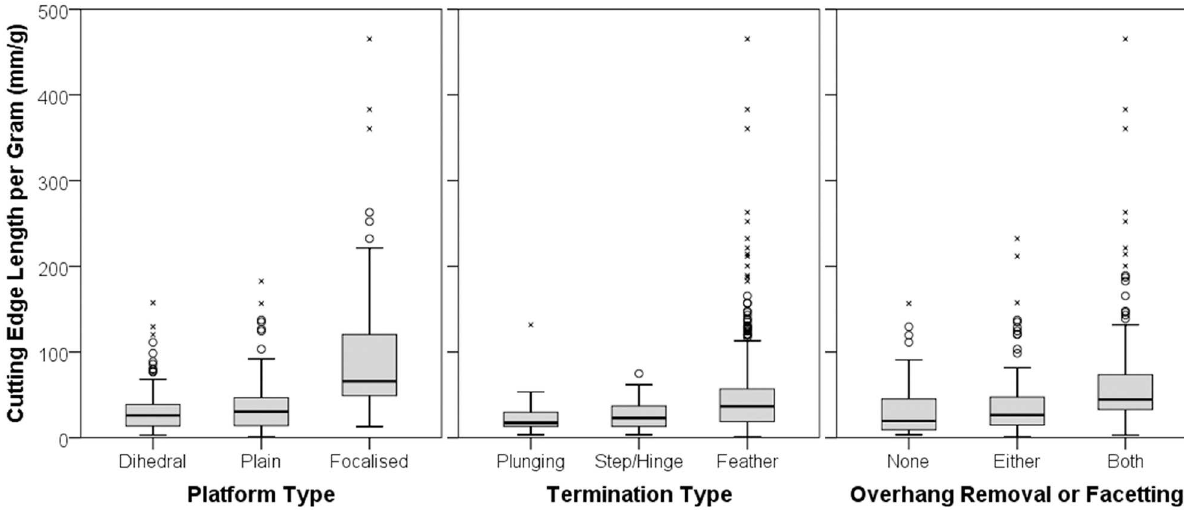
Fig 5. Boxplots of qualitative variables. Platform type plot (a) compares dihedral( N = 178; Mdn = 25.99), plain ( N = 182; Mdn = 30.52) and focalised( N = 100; Mdn = 65.81) platforms. Termination type plot (b) comparesplunging( N = 22; Mdn = 17.45), step or hinge ( N = 58; Mdn = 23.02) and feather ( N = 408; Mdn = 36.45) terminations. Platform preparation plot (c) comparesno preparation ( N = 105; Mdn = 19.49), either overhangor faceting ( N = 202; Mdn = 26.44) and both overhangand faceting ( N = 181; Mdn =